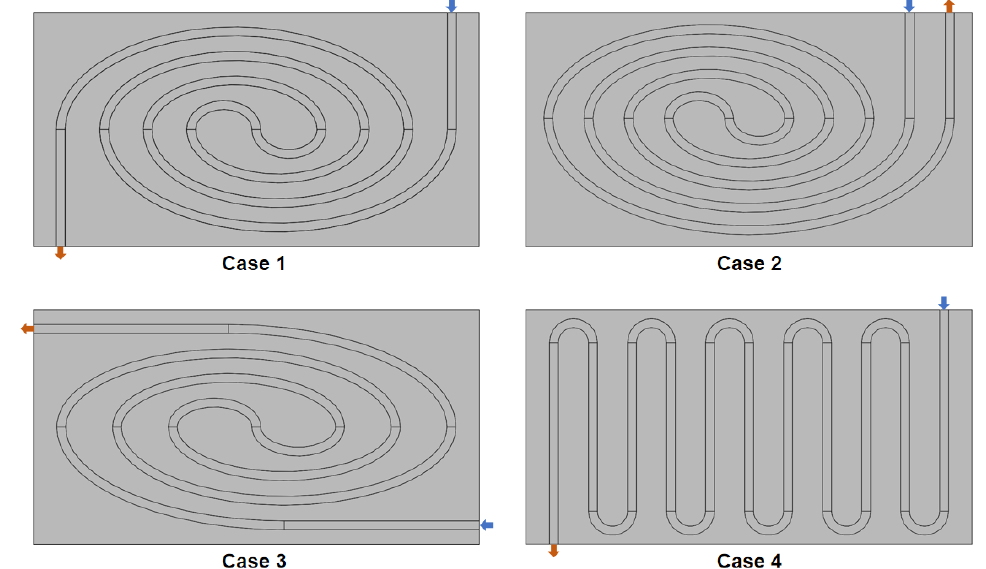
Figure 5. The four layouts of the channels named Case 1 to Case 4.